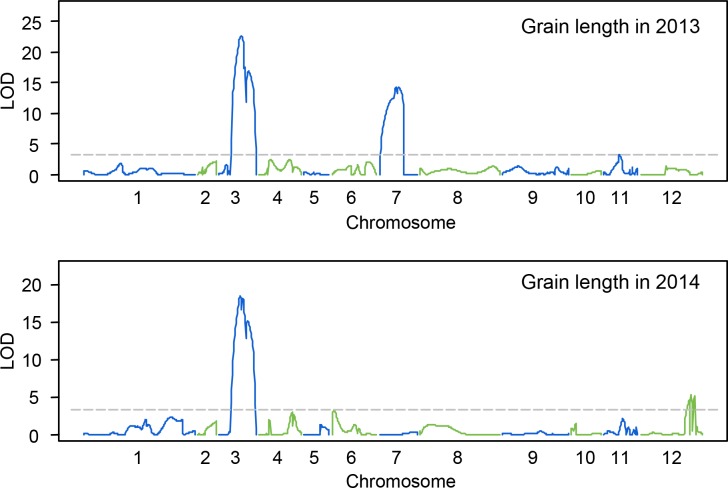
Graph for QTL mapping results of grain length of BC3F1 population in 2013 and 2014.